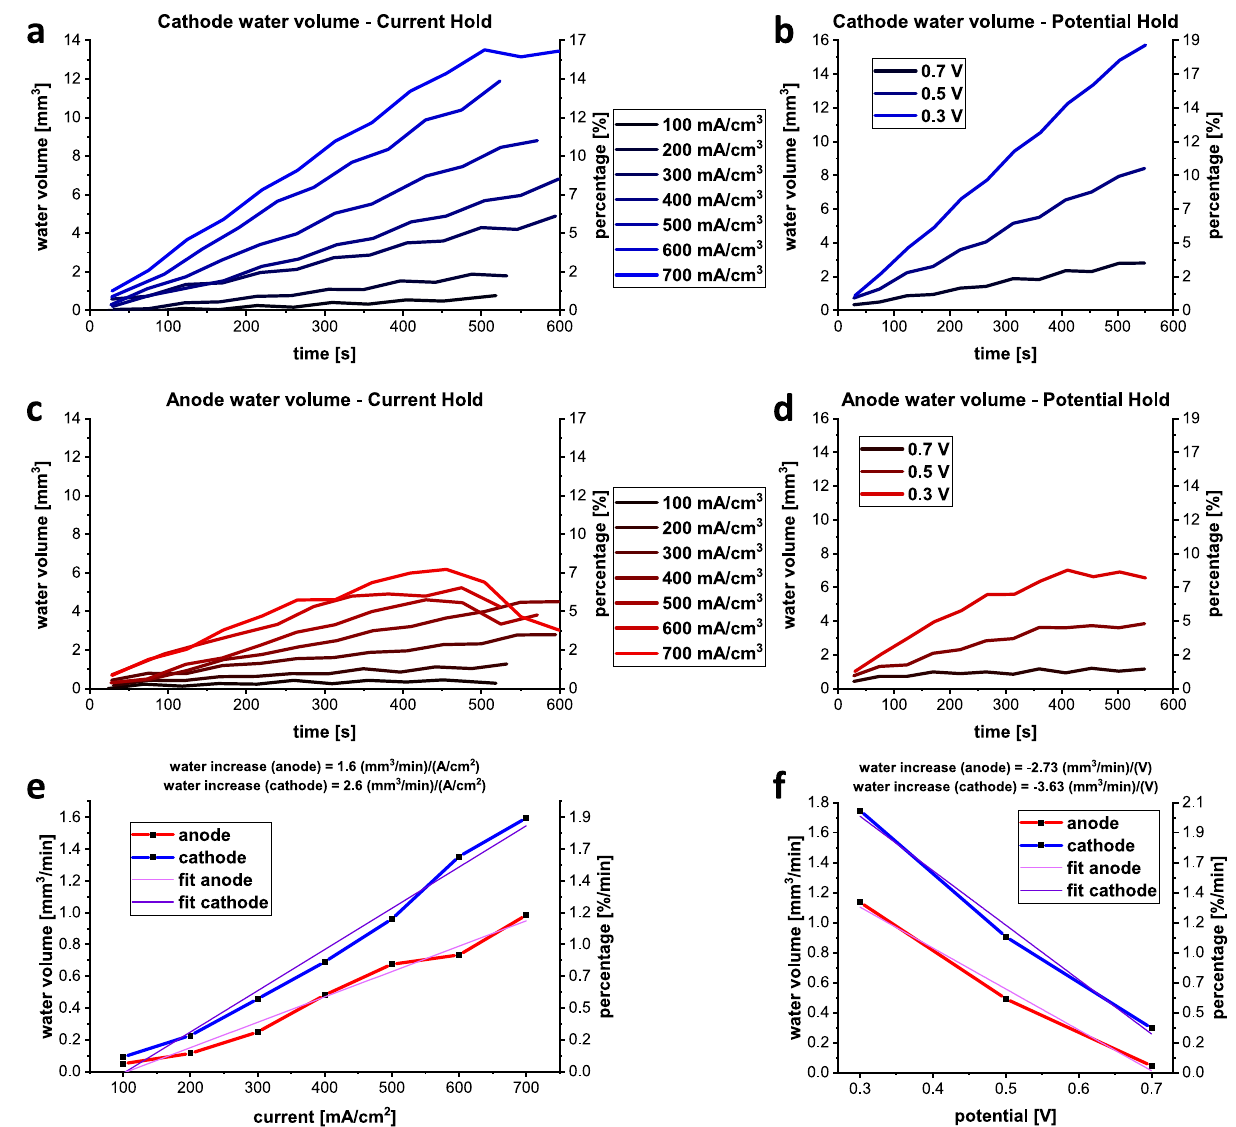
Fig. 3 Water volumes in the cathode and anode fl ow fi elds during constant current and potential hold. The water volumes increase with increasing current density and decreasing potential for the cathode ( a , b ) and anode ( c , d ) side with a greater water volume accumulating at the cathode. After a short time, the water amount appears to reach a maximum dependent on the current and potential height before starting to expel water. Graphs e and f show the water volume changes as a function of the current and potential, respectively, for anode and cathode fl ow fi elds. The slopes of the linear regressions represent the current/voltage and time-dependent water volume